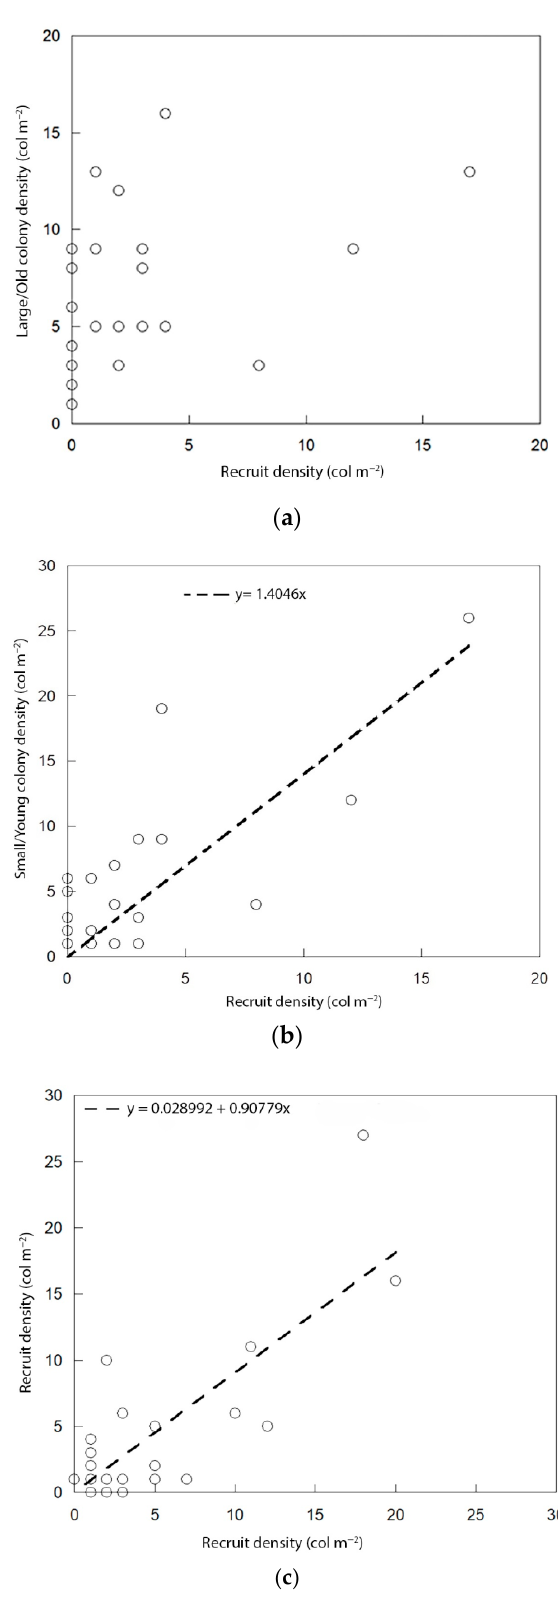
Figure 6. Trends of recruit and colony density: ( a ) density of recruits vs. that of larger/older colonies; no linear trend was found; ( b ) density of recruits vs. that of small/young colonies; a linear trend emerged; ( c ) recruit density measured in the same photo sample in two successive years (2007 vs. 2008 and 2009 vs. 2010) and the linear trend.